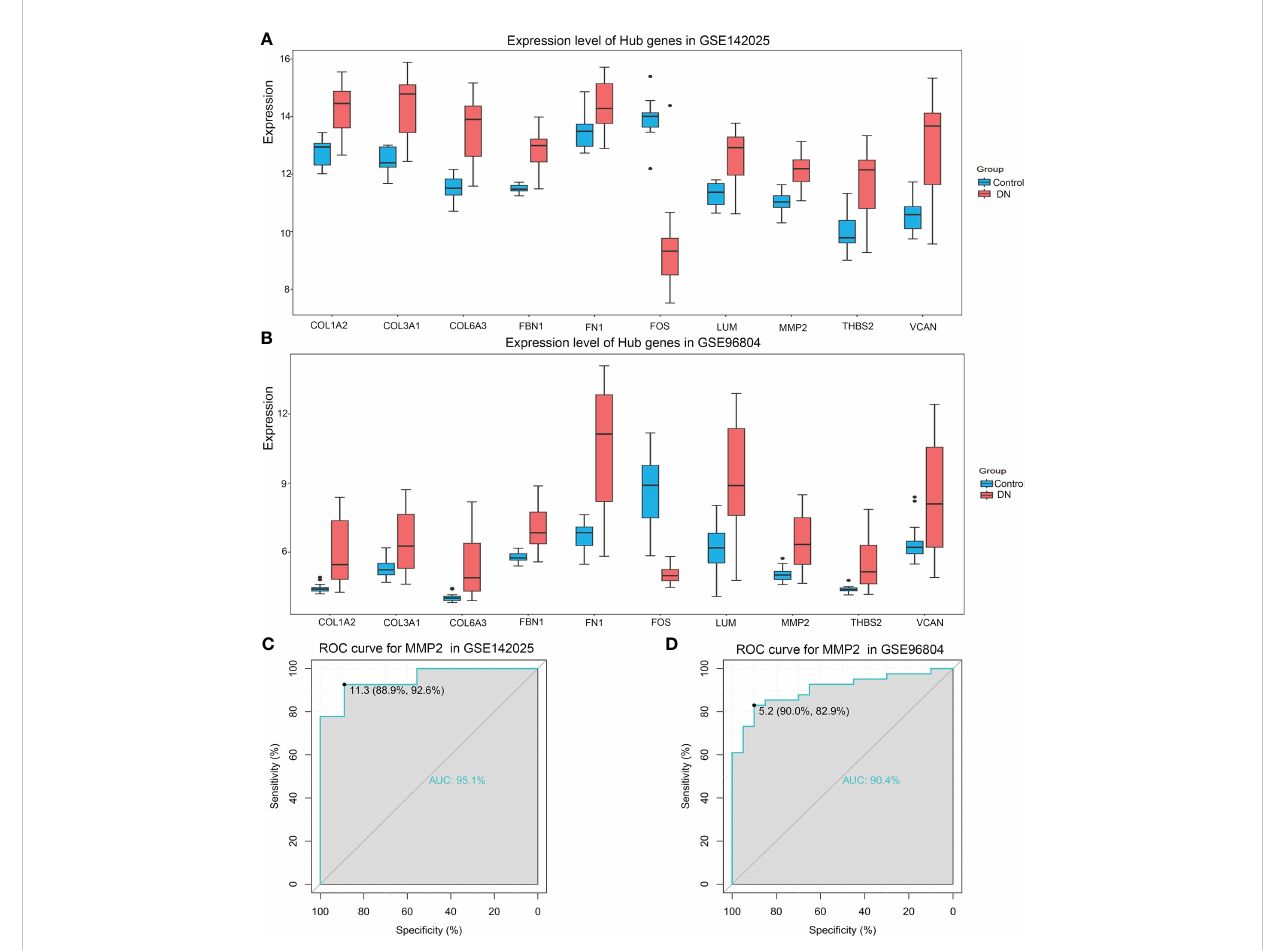
FIGURE 5 (A) Expression levels of hub genes in data sets GSE142025, (B) GSE96804, all P-value<0.05. (C) Receiver Operating Characteristic (ROC) curves of MMP2 in GSE142025, (D) GSE96804. The area under the curve (AUC) were 95.1% and 90.0%, respectively.